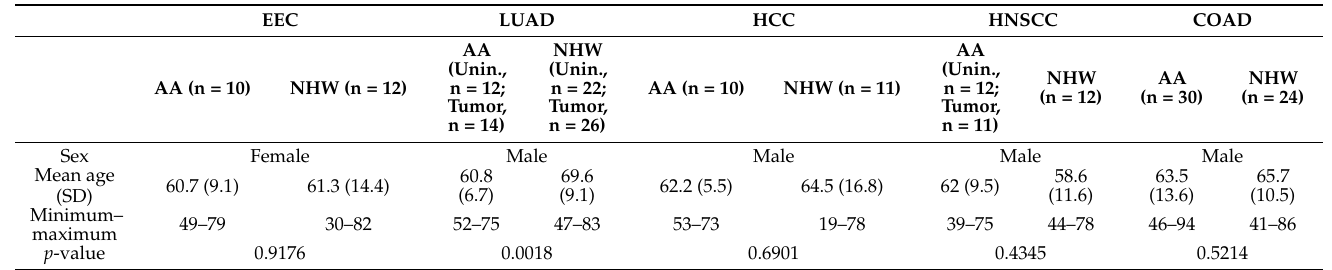
Table 1. The characteristics of subjects in lipidomic analysis cohort by disease, race, and sex. p -values are for comparisons between the ages of subjects in each group and were analyzed using a two-tailed student’s t -test with α =